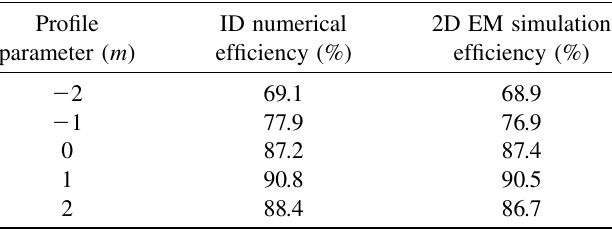
TABLE I. Power transmission efficiencies of the design I impedance transformer with various impedance profiles from Eq.